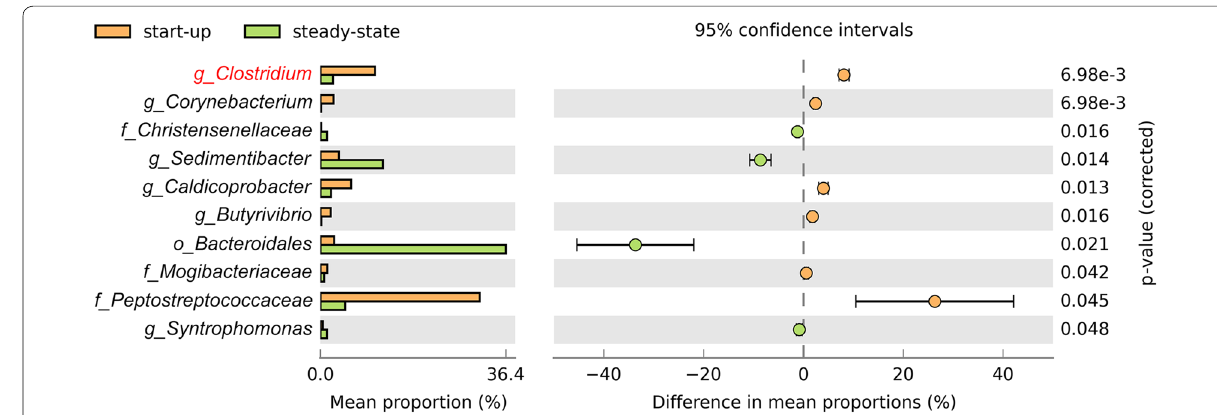
Fig. 4 Genera that changed significantly (p < 0.05) during the steady-state, compared to the start-up phase. No statistically significant changes are observed between genera compositions in the start-up phase and the